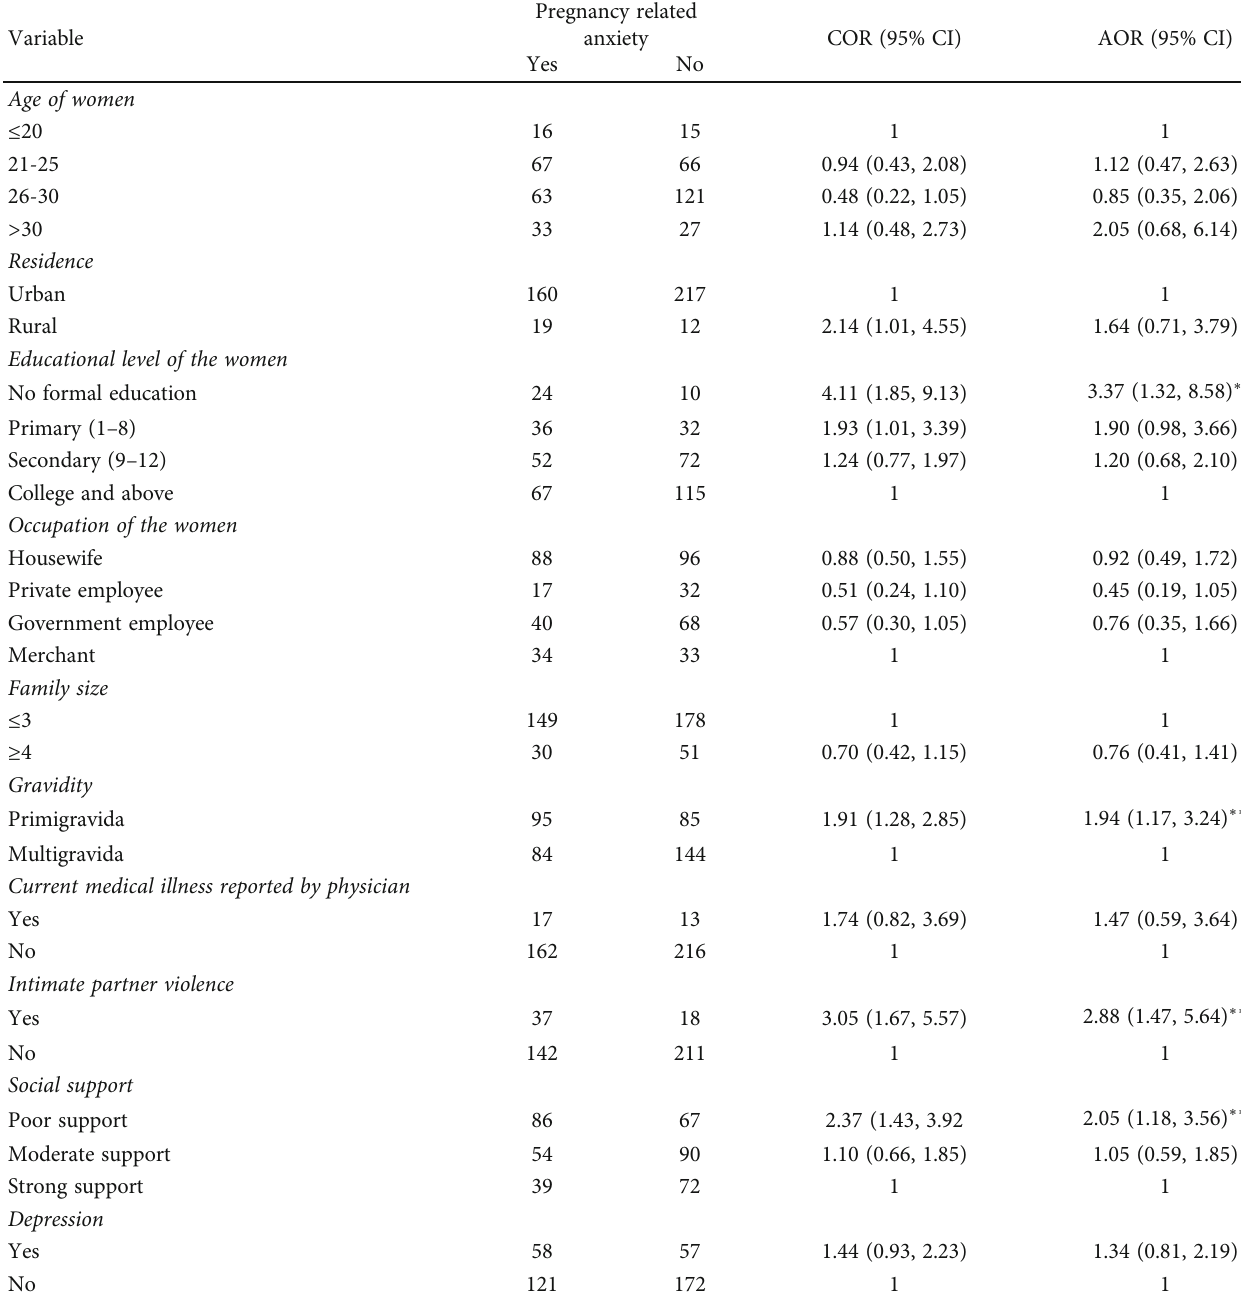
Table 4: Bivariable and multivariable logistic regression analysis of factors associated with pregnancy related anxiety among